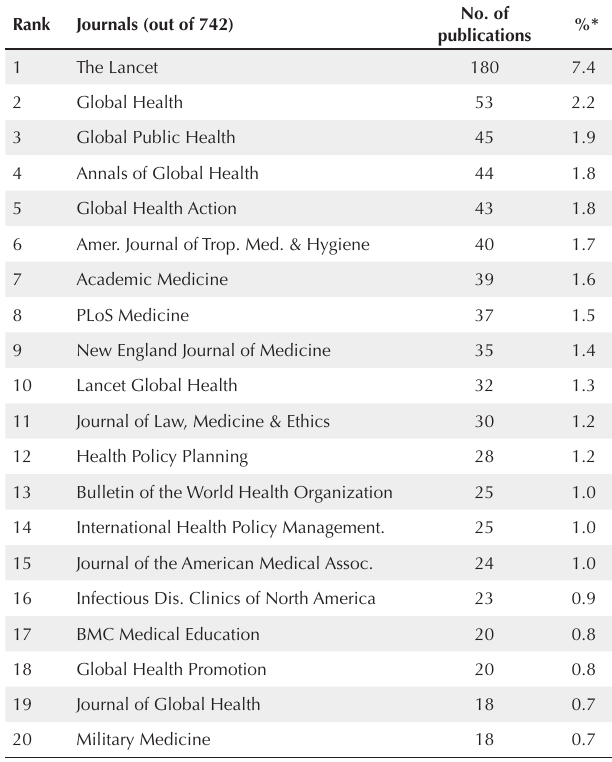
Table 3. Number of Publications by